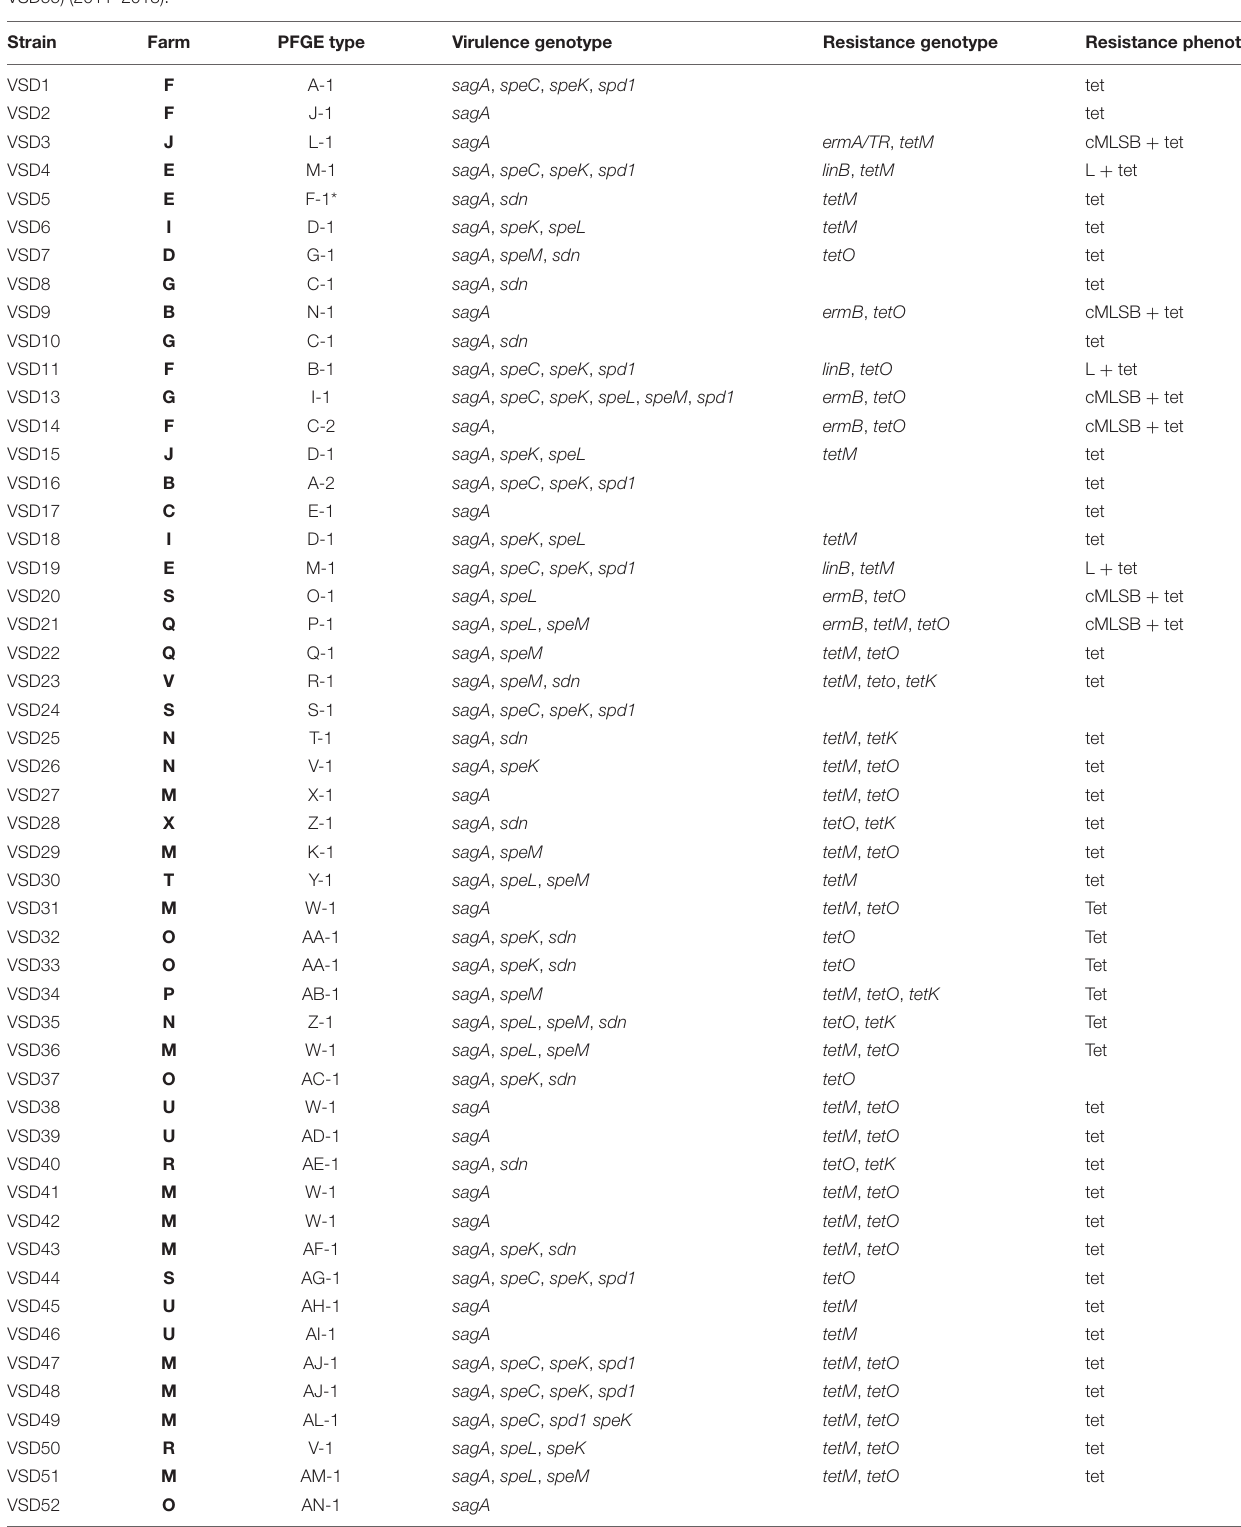
TABLE 1 | Characterization of bovine SDSD isolates from collection I (VSD1 to VSD11 and VSD13 to VSD19) (2002–2003) and from collection II (VSD20 to VSD55) (2011–2013). Strain Farm PFGE type Virulence genotype Resistance